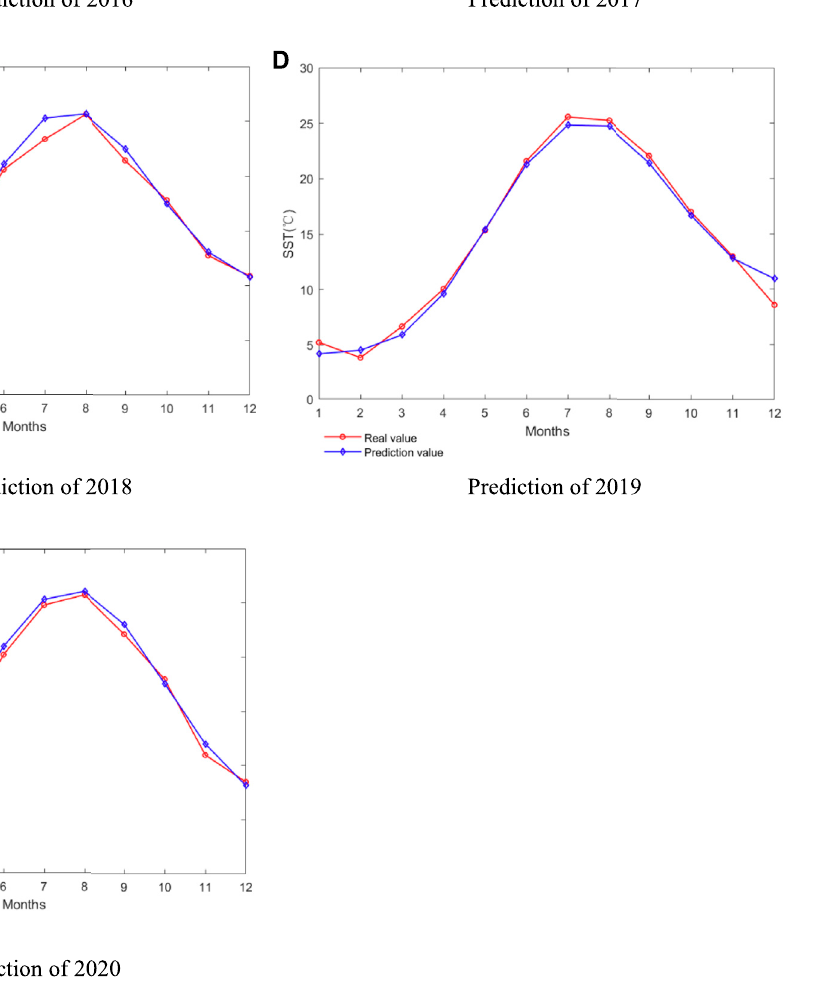
FIGURE 8 Consecutive prediction of the recent 5